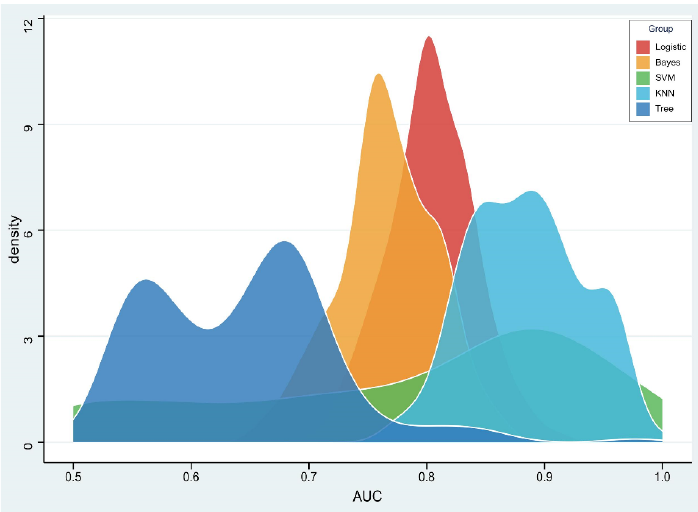
Figure 3. Plot of regression coefficients for retained radiomics features.